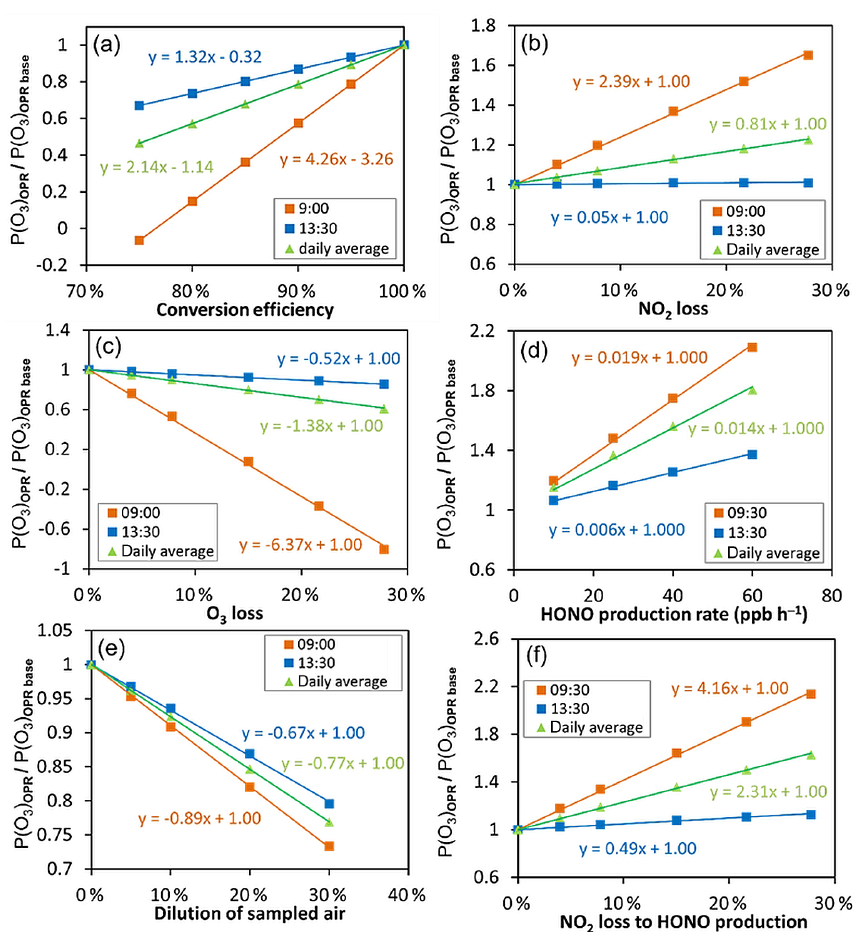
Figure 7. Sensitivity tests performed for 30 May 2010 (CalNex 2010) to assess the impact on the P (O x ) measurements of the (a) O 3 -to-NO 2 conversion efficiency, (b) NO 2 and (c) O 3 dark losses, (d) heterogeneous HONO formation, (e) dilution of ambient air and (f) NO 2 loss towards HONO production in the flow tubes. The results presented here correspond to the 2h of the day identified as lower (blue squares) and upper (orange squares) limits of the impact on the P (O x ) measurements. The daily average behavior is also shown using green